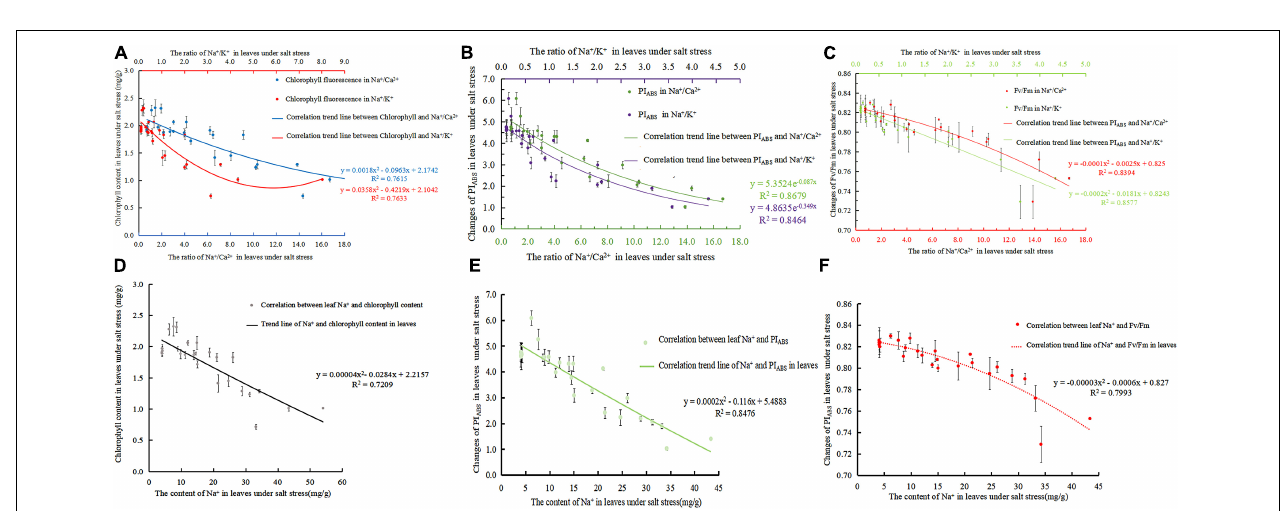
FIGURE 2 | Changes and correlation of Na + ,Na + / K + and Na + / Ca 2 + in roots and leaves of S. matsudana under salt stress; (A) changes of Na + / K + in roots and leaves under salt stress; (B) changes of Na + / Ca 2 + in roots and leaves under salt stress; (C) changes of Na + in roots and leaves under salt stress; (D) correlation between Na + / K + and Na + / Ca 2 + in leaves under salt stress; (E) correlation between Na + in leaves and roots under salt stress.